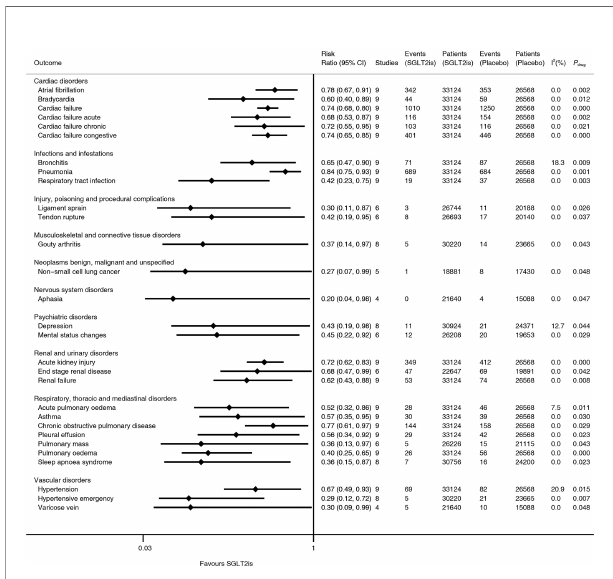
FIGURE 1 | Meta-analyses of SGLT2is and 29 kinds of serious adverse events. SGLT2is, sodium-glucose cotransporter 2 inhibitors; CI, con fi dence interval; p drug , p for drug